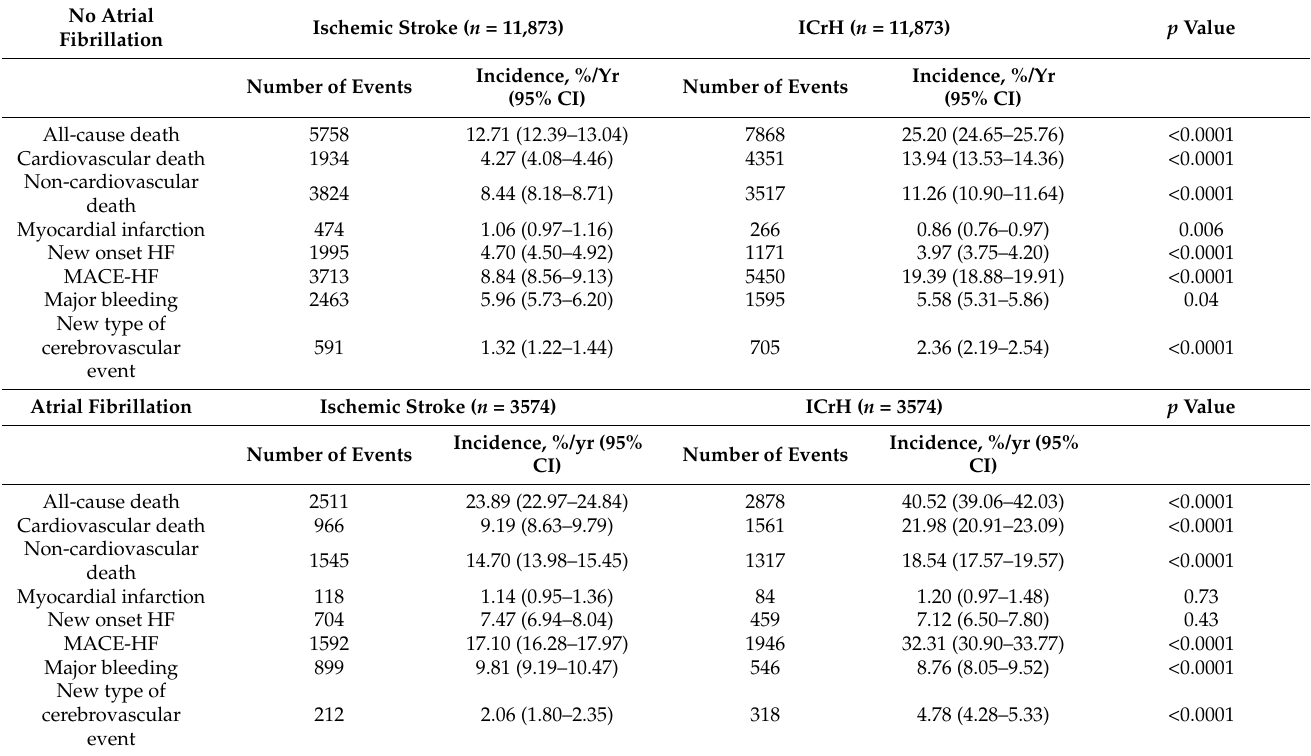
Table 2. Incident outcomes in the matched population with and without comorbid atrial fibrillation in ischemic stroke and non-traumatic intracranial hemorrhage survivors.